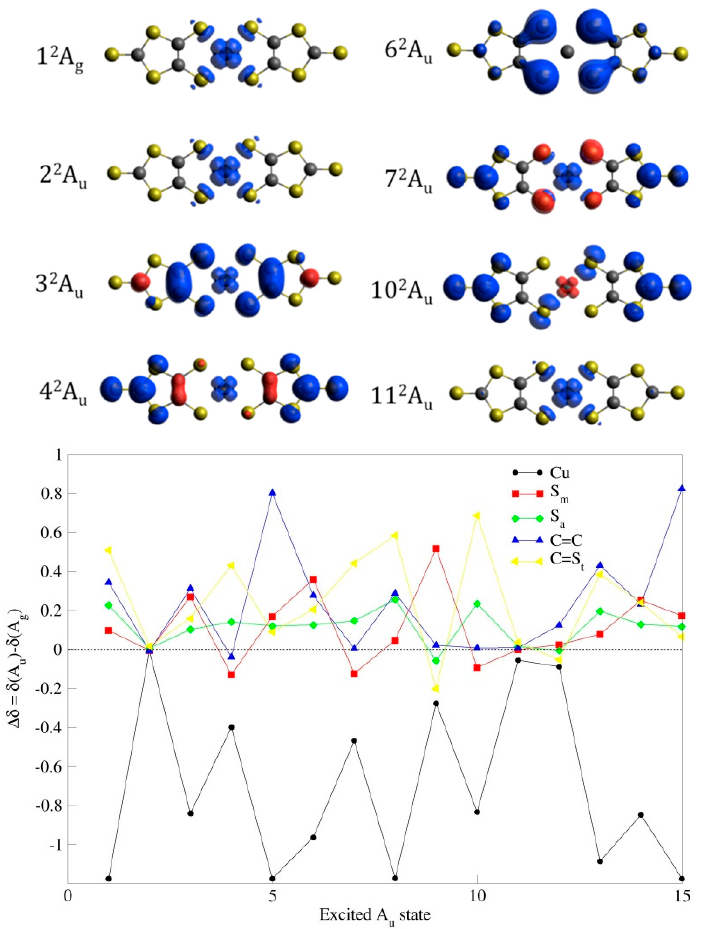
Figure 5. ( top ) Spin density maps for the ground state and excited A u states involved in the main UV–Vis absorption bands. ( bottom ) Changes in the spin populations on Cu atom (black), S m atoms (red), S a atoms (green), C1–C2 atoms (blue), and C=S t atoms (yellow) between the ground state and the different Au excited states.